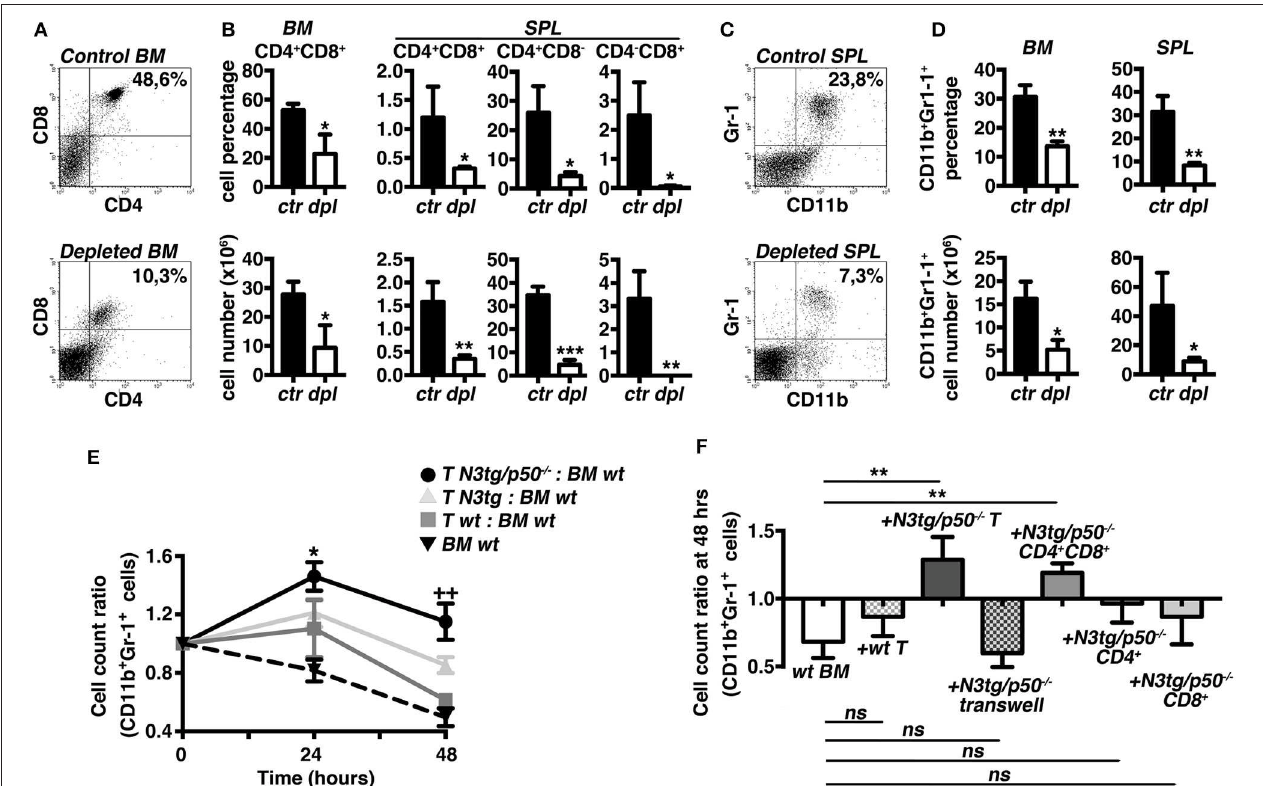
FIGURE 5 | T cell compartment drives the expansion of myeloid cells in N3tg/p50 − / − mice. Three weeks-old N3tg/p50 − / − mice were injected i.p. with anti-CD4 plus anti-CD8 depleting antibodies or with relative isotype controls, bi-weekly for 3 weeks. (A) Representative dot plots showing CD4 vs. CD8 distributions in the BM of control ( upper panel ) or T-cell depleted ( lower panel ) N3tg/p50 − / − mice, as measured by FACS analysis. Numbers inside each cytogram represent the percentages of DP T cells. (B) Percentages ( upper panels ) and absolute numbers ( lower panels ) of BM CD4 + CD8 + (DP) T cells and of (DP) T, CD4 + CD8, − and CD4 − CD8 + splenocytes from control vs. T-cell depleted N3tg/p50 − / − mice ( ctr and dpl , respectively), measured as in (A) . (C) Representative dot plots showing CD11b vs. Gr-1 distributions in the SPL of control ( upper panel ) or T-cell depleted ( lower panel ) N3tg/p50 − / − mice, as measured by FACS analysis. Numbers inside each